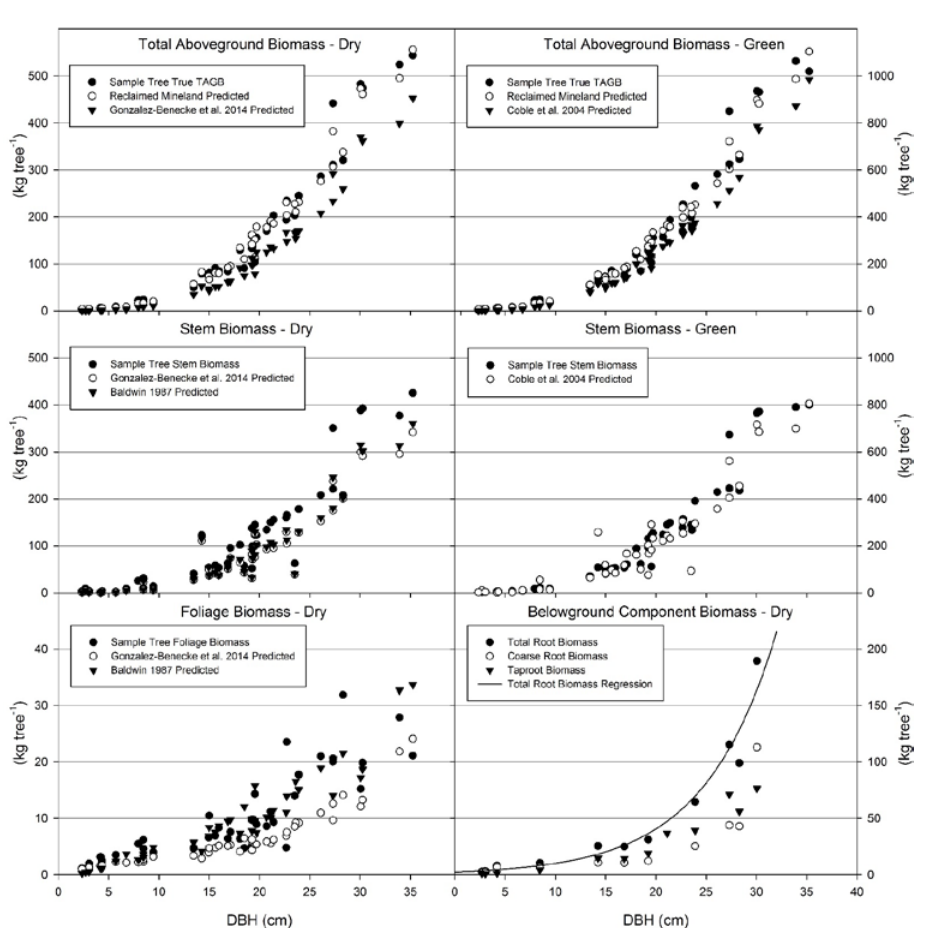
Figure 4. Total aboveground biomass (green and dry), stem biomass (green and dry), foliage biomass (dry), and belowground biomass (dry) for sample trees on reclaimed mineland. Actual sample tree biomass, predicted biomass from the models in Table 3, and/or predicted biomass from unmined datasets are displayed. Although displayed by diameter at breast height, each predicted value utilizes the same DBH (diameter at breast height), HT (total height), and AGE (tree age) values of the sampled trees. Total aboveground biomass, either green or dry, is therefore greater on mined sites than unmined sites when trees are a similar size. Stem biomass is generally greater for trees on mined sites than unmined sites. Foliage biomass predicted by reclaimed mineland models did not exceed predicted values from the unmined model of Baldwin [33]; however, foliage biomass was greater on mined sites than values of Gonzalez-Benecke, et al. [31]. Component and total biomass of roots are displayed, as well as the total belowground biomass prediction equation. Belowground biomass data could not be compared to unmined